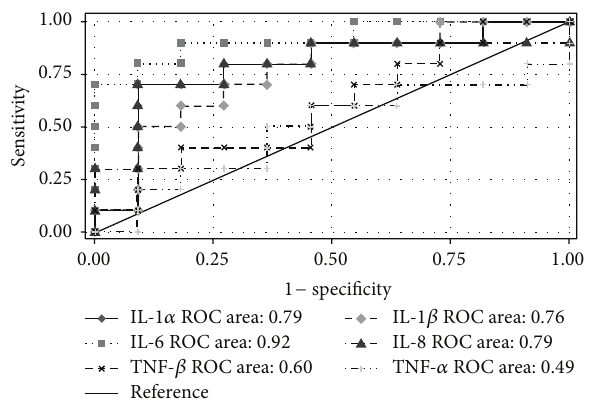
Figure 2: Receiver operating characteristic (ROC) curve and area under the curve (AUC) of proinflammatory cytokines for predicting the treatment